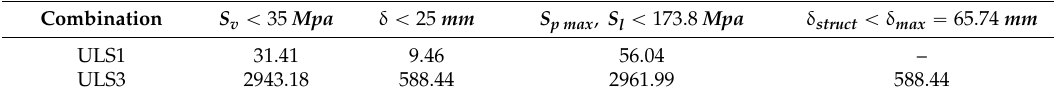
Table 4. Results obtained for the two selected load conditions.